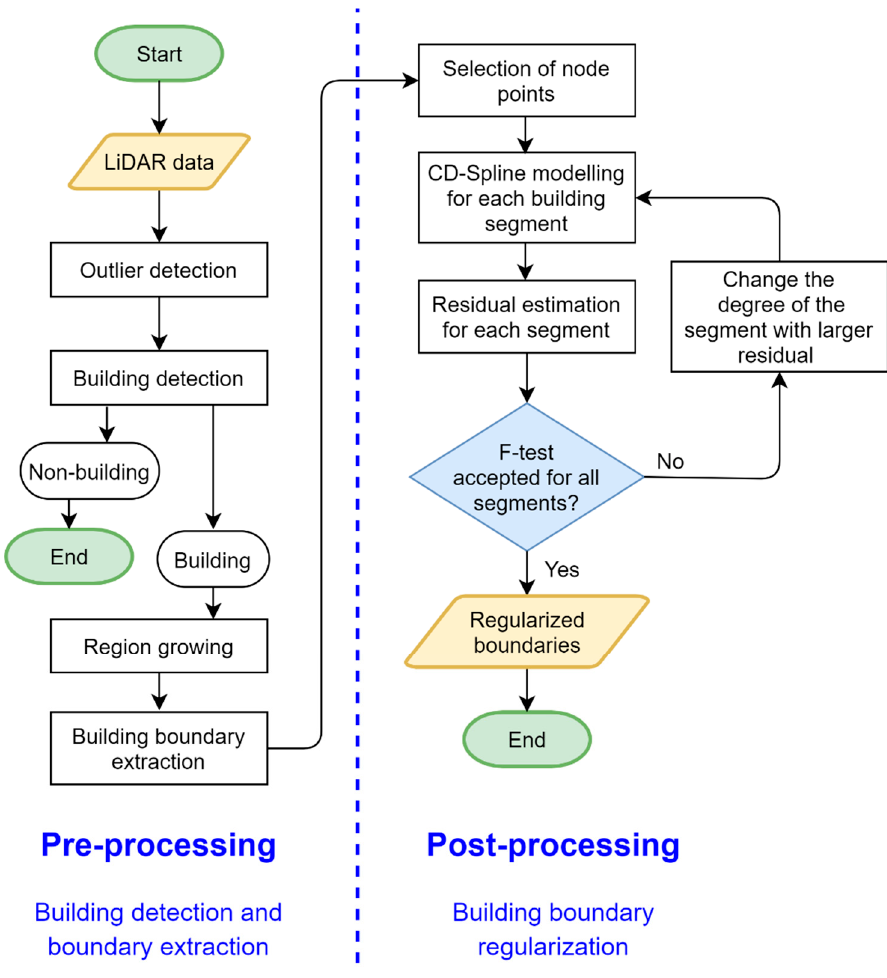
Figure 2. Flowchart of the proposed method.